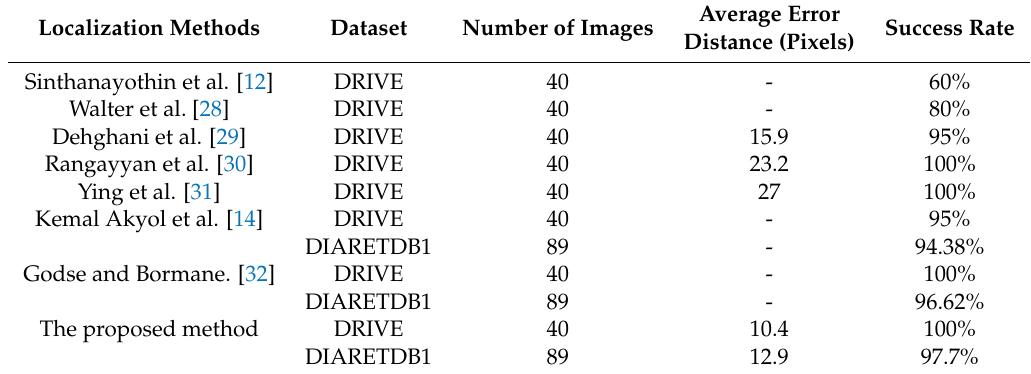
Table 2. Results of different